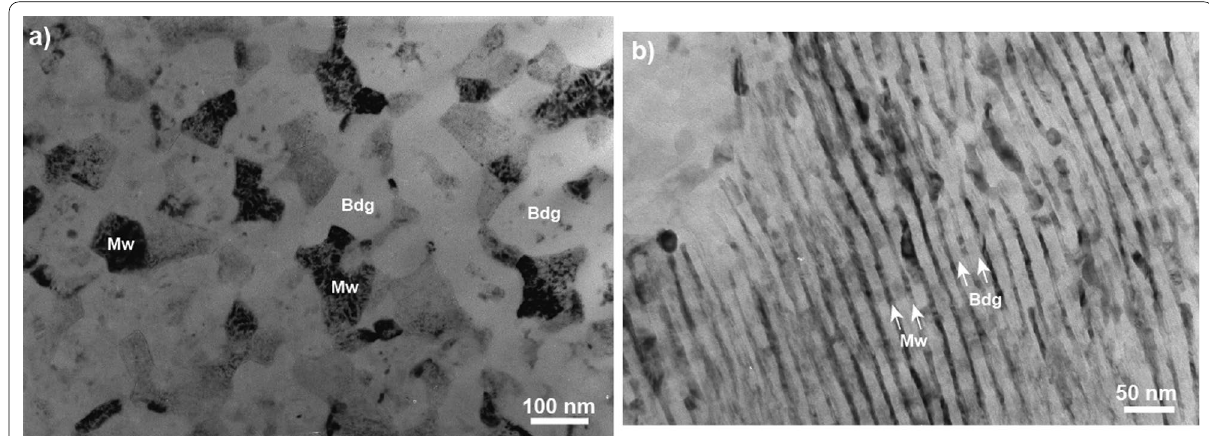
magnesiowüstite, b lamellar +